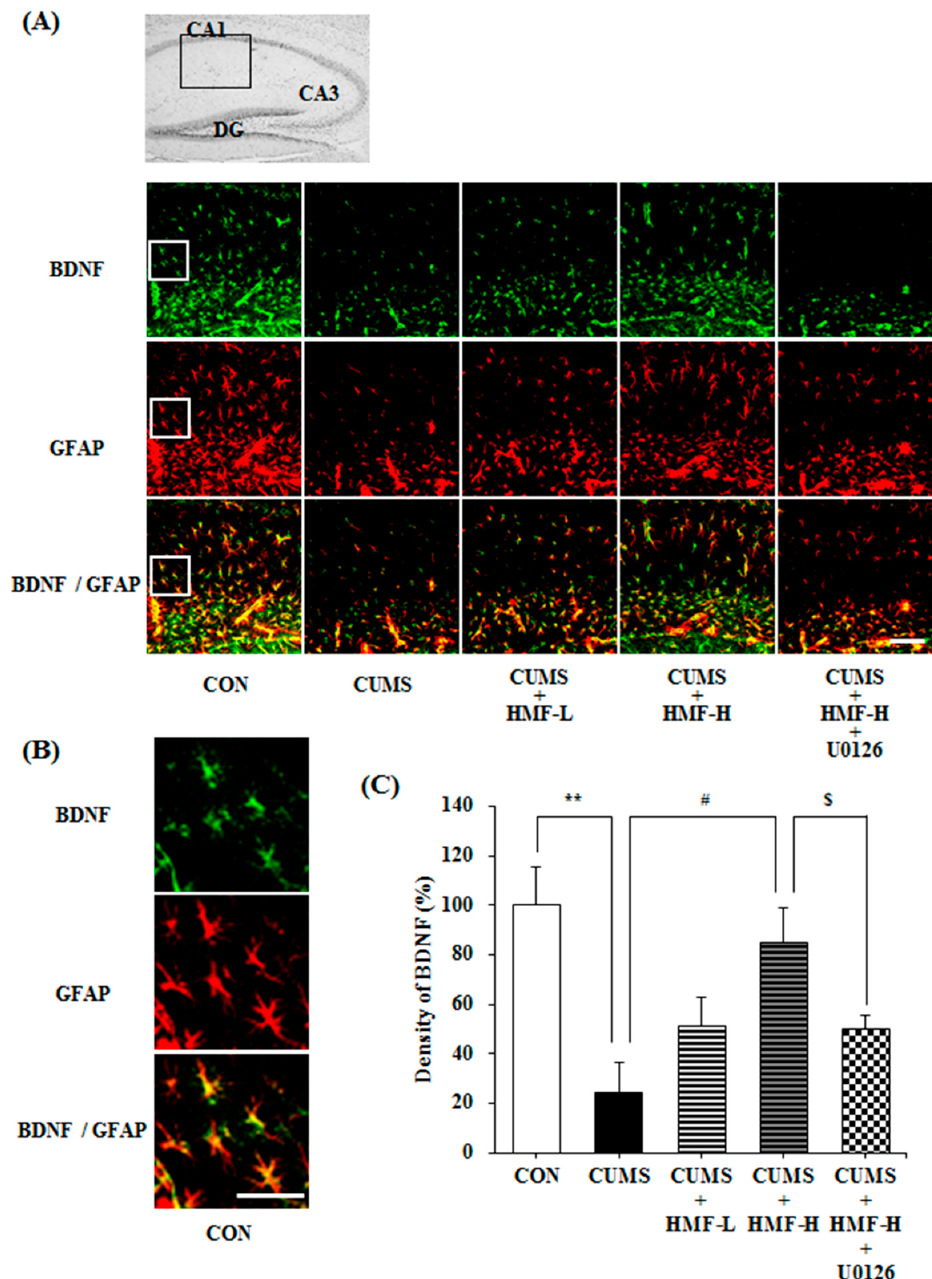
Figure 7. Effects of HMF on the expression of BDNF and glial fibrillary acidic protein (GFAP) in the CUMS-treated mouse hippocampus on Day 16. ( A ) Immunoreactivities of BDNF (green) and GFAP (red) with lower magnification. Merged images were shown in yellow. The white scale bar shows 100 µ m. The portion for the quantitative analysis was shown with a black square. ( B ) Immunoreactivities of BDNF (green) and GFAP (red) with higher magnification. Merged images were shown in yellow. The white scale bar shows 100 μ m. The portion for the enlargement was shown with a white square in ( A ). ( C ) A quantitative analysis of BDNF densities of the total areas of ( A ). Values are means ± SEM ( n = 6–8). Symbols show significant differences between the following groups: CON vs. CUMS (** p < 0.01, the Student’s t -test), CUMS vs. CUMS + HMF-H ( # p < 0.05, one-way ANOVA followed by the post-hoc Williams multiple comparison test) and CUMS + HMF-H vs. CUMS + HMF-H + U0126 ( $ p < 0.05, the Student’s t -test).CA, cornu ammonis; DG, dentate gyrus.